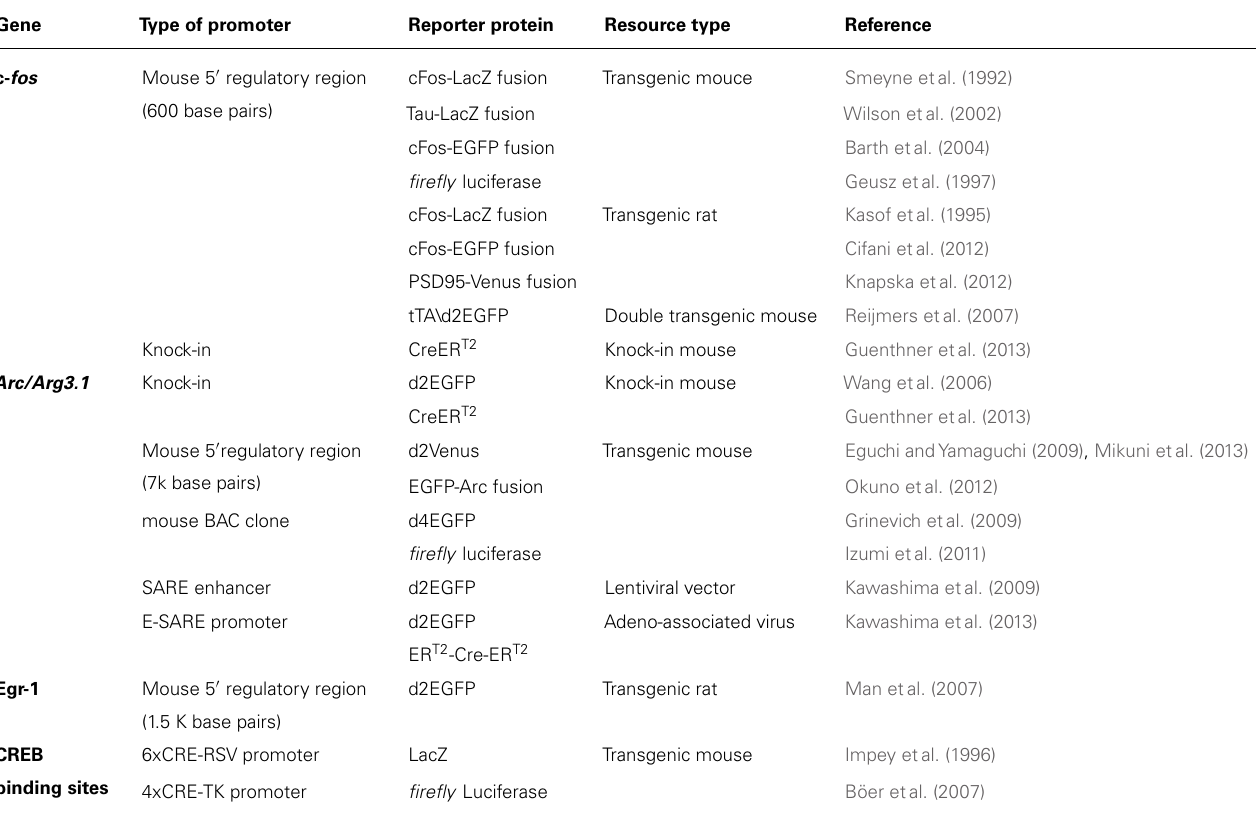
Table 1 | Reporter mouse lines and viruses based on activity-dependent